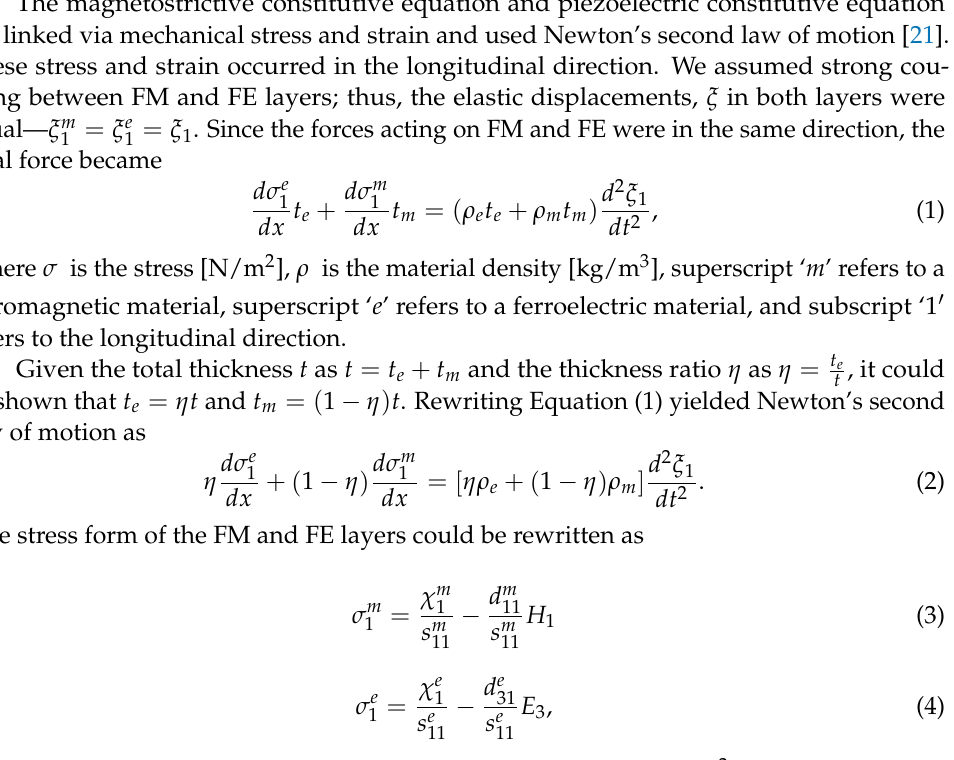
Figure 2. The bi–layer L–T mode bar